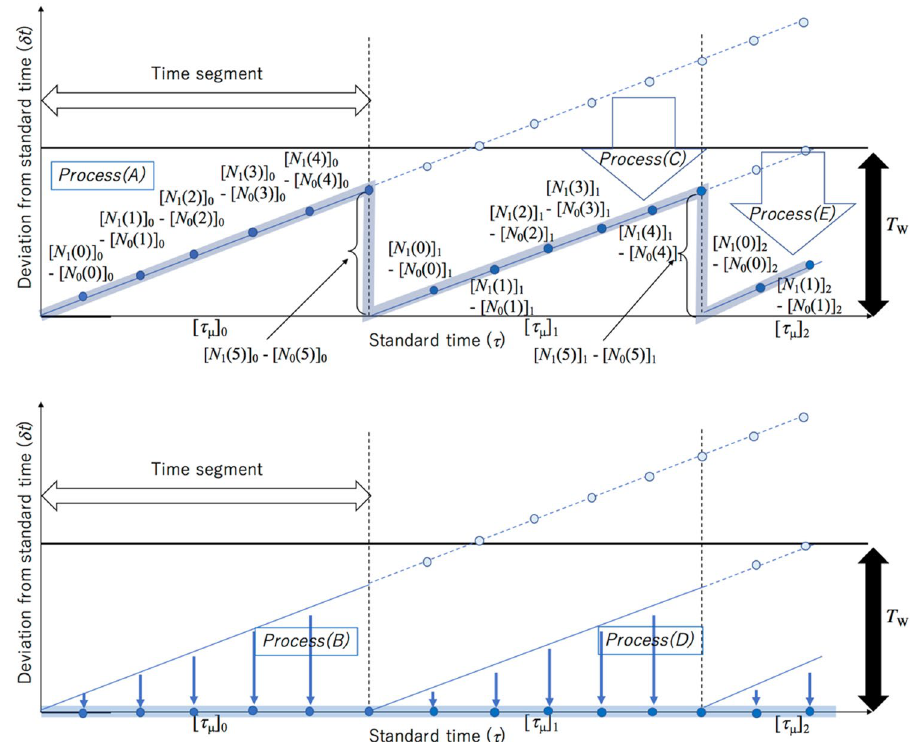
Figure 3. Procedure of the resynchronization process. Blue circles indicate the discrete local timelines that are represented by the clock pulse counts. Filled and blank blue circles respectively indicate the discrete local timelines before and after calibration. Bold blue lines in the bottom panel indicate the recalibrated timeline. Processes ( A )–( E ) are indicated in the top panel and the bottom panel, respectively. In this specific case, i = 1 and n 0 = 5.The notations of the symbols in this figure are described in the main